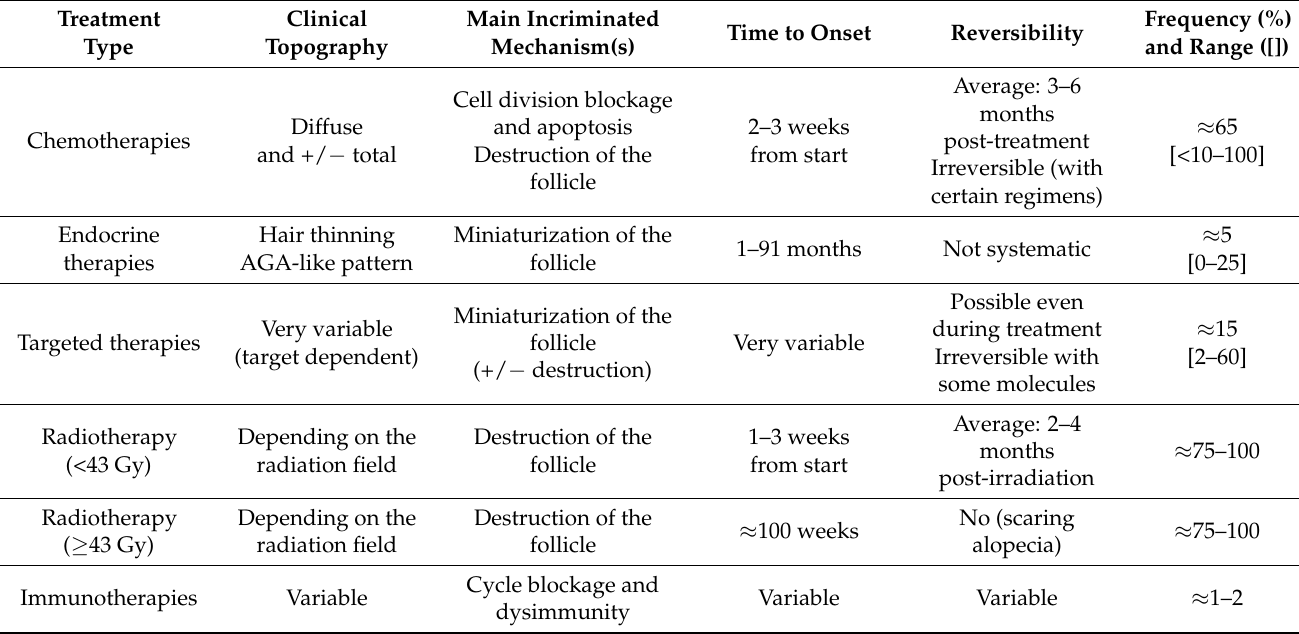
Table 1. Main characteristics of hair disorders according to the anticancer therapies used (adapted from references [7–14]).